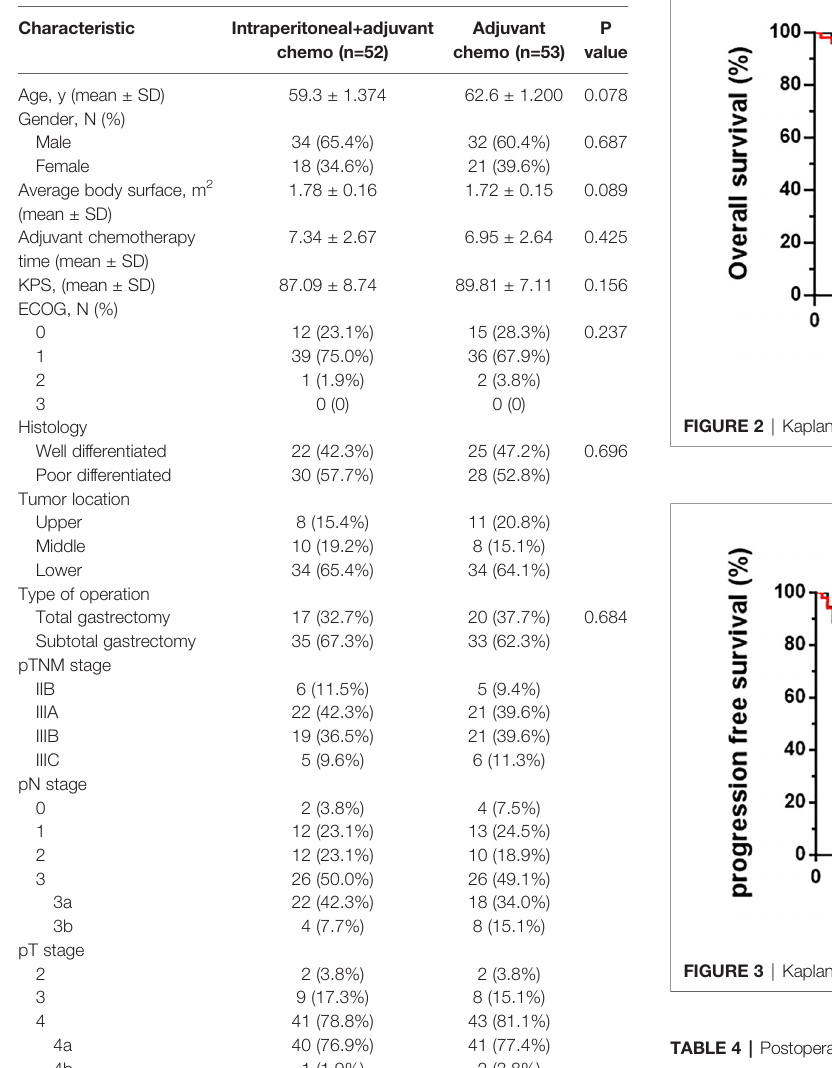
TABLE 1 | Clinicopathological features of the included participants.